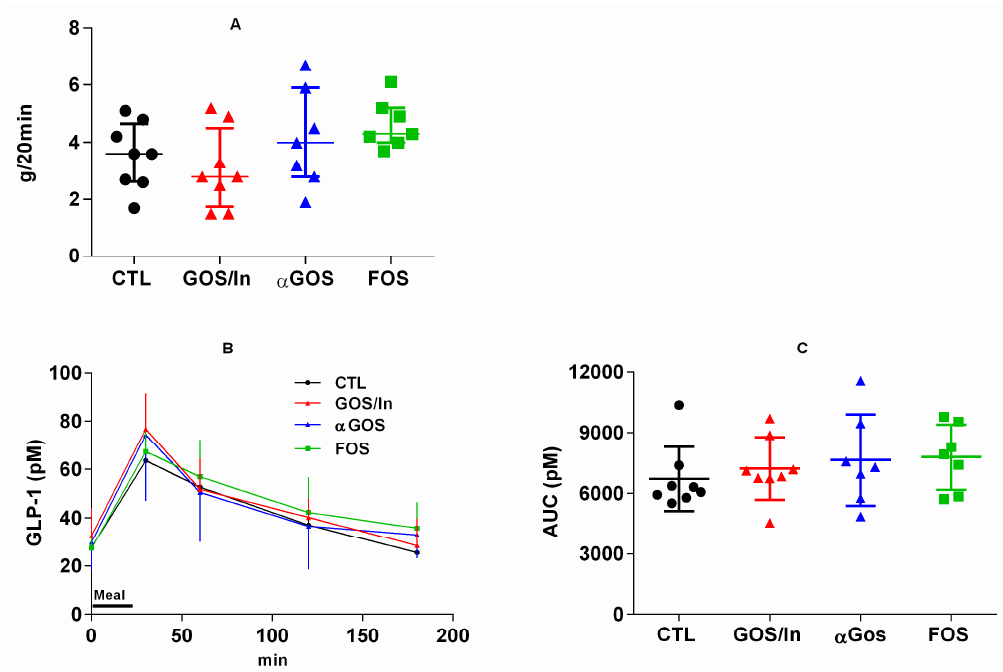
Figure 7. Fasting-refeeding test. ( A ) Food intake measured during refeeding (20 min-meal); ( B ) Plasma concentration of total GLP-1 measured during the 3h-kinetic follow-up (means ± SD); ( C ) Total amount of GLP-1 secreted during the 0-180min period expressed as AUC. Individuals, means and SD are plotted. ( n = 7 to 8 per groups).